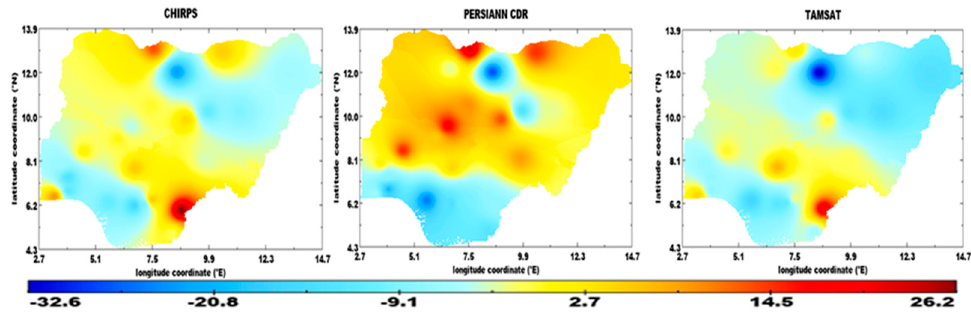
Figure 7. Percent bias (PBIAS) of mean JJAS rainfall.